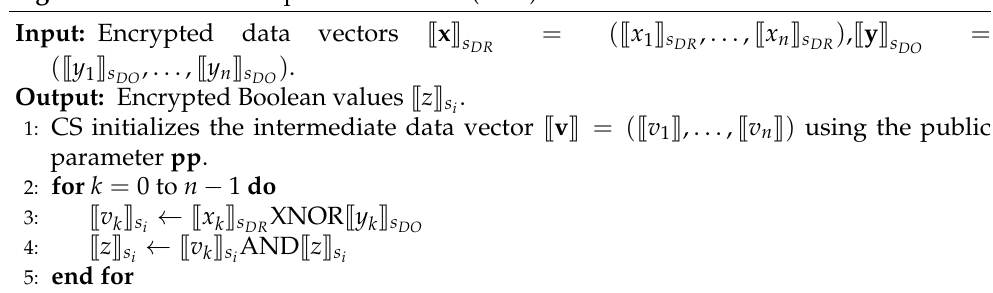
Algorithm 4 Secure Comparison Protocol ( SCP